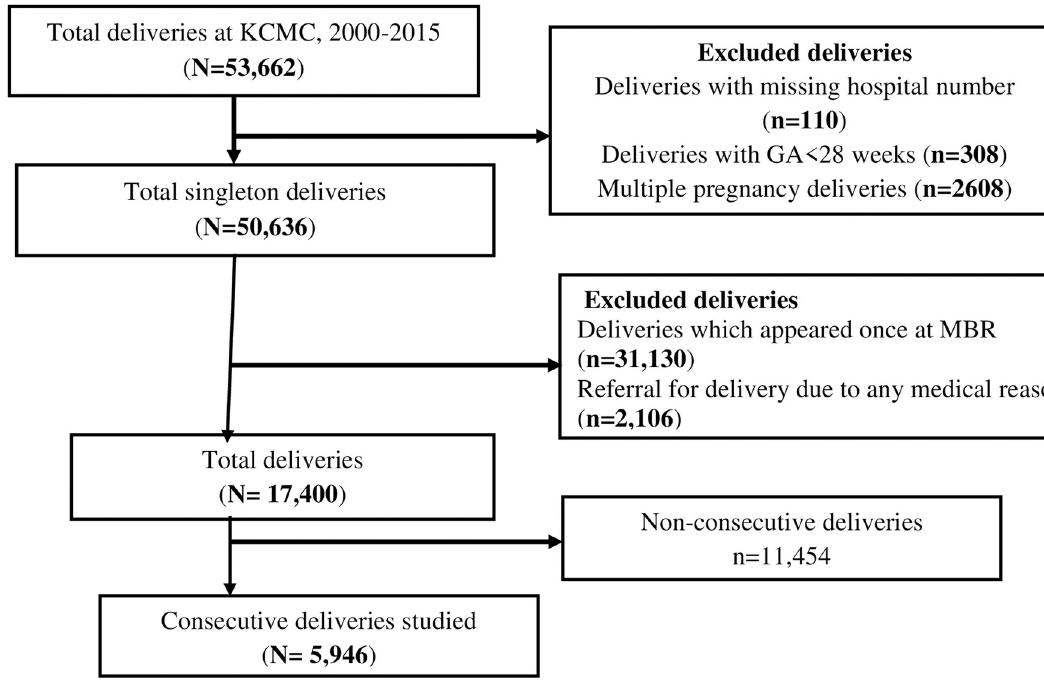
Fig 1. Flow chart of the number of deliveries, inclusions and exclusions during the study